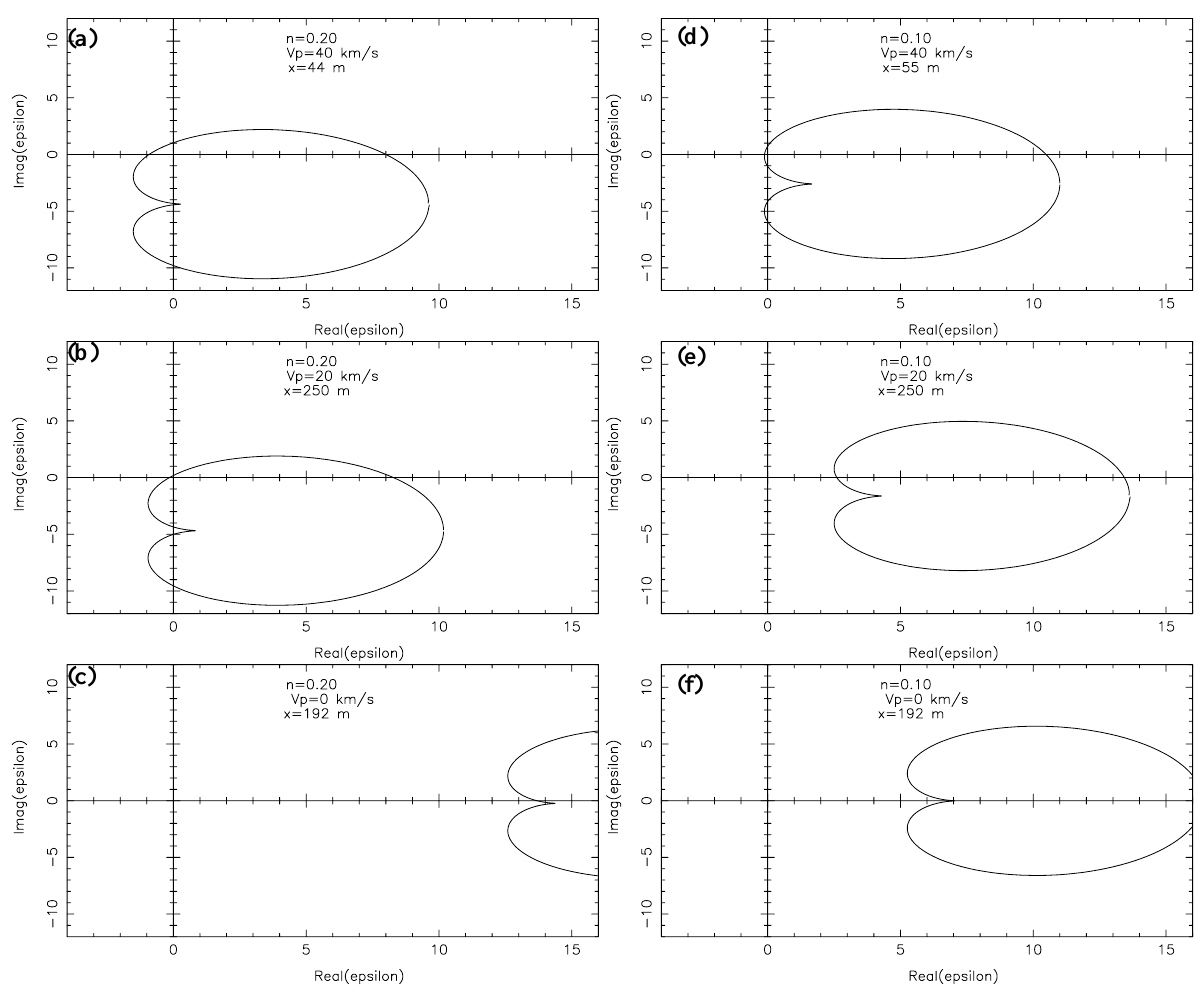
Fig. 6. The plasma dispersion curve C (cid:15) , found by mapping the curve C ω for the EDFs shown in Fig. 5. ≈ 30 mV/m for k ⊥ ≈ 1 /ρ i , which when multiplied by 1 /